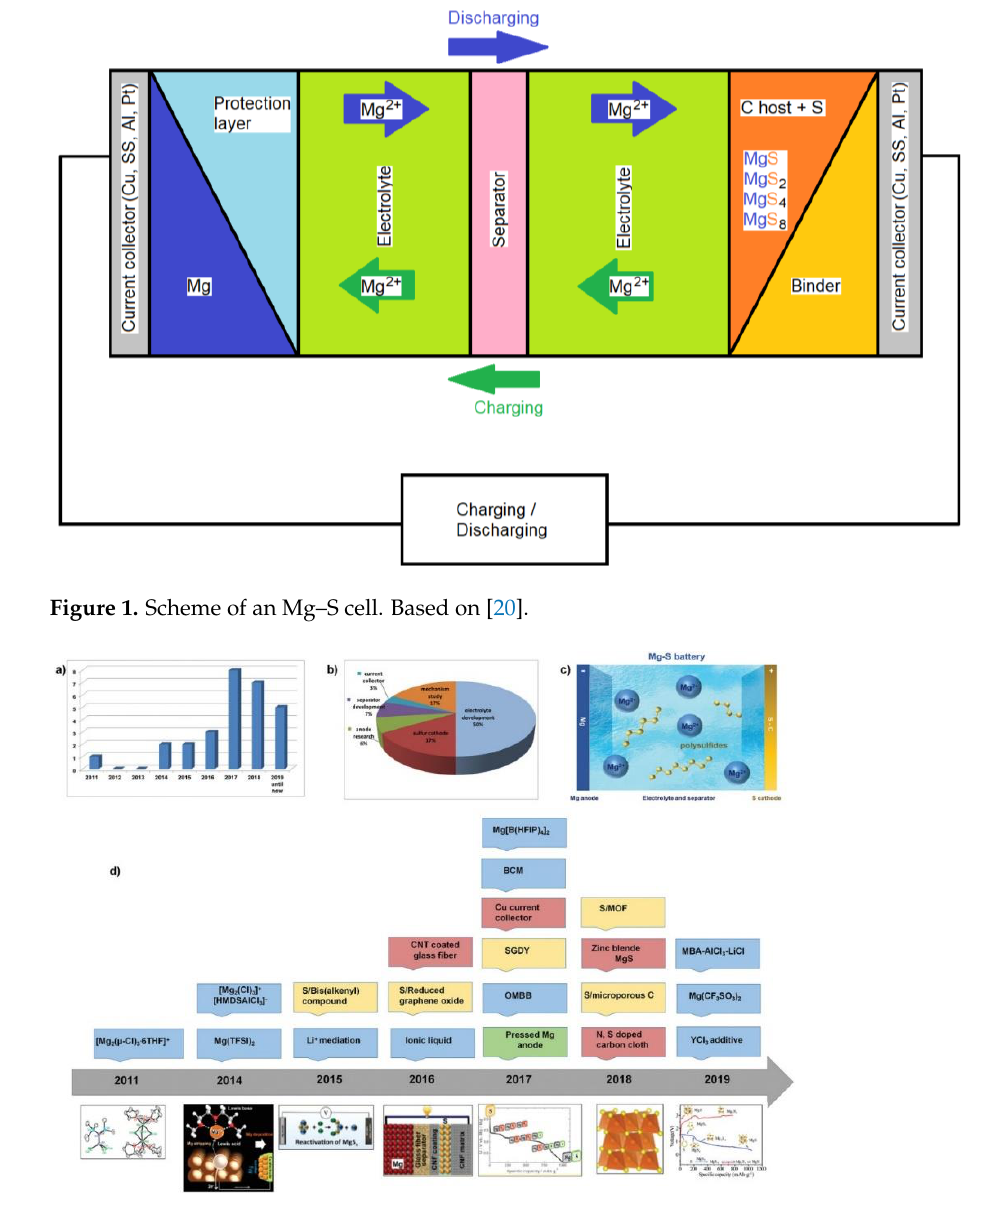
Figure 2. Development of Mg–S cells: ( a ) The increased trend of studies on Mg–S cells, number of papers on Mg–S cells since 2011; ( b ) a comparison of topics addressed in all papers related to Mg–S cells; ( c ) a scheme of an Mg–S battery with an S-based cathode and an Mg anode, separated by a separator and the electrolyte. Mg 2+ ions are generated during electrochemical reaction of the Mg anode with the S cathode; ( d ) findings in the time range from 2011 to 2019 on Mg–S cells concerning electrolyte (blue), S-based cathode (yellow), anode (green), and current collector and separator (pink). Taken from [16] based on [21–27].